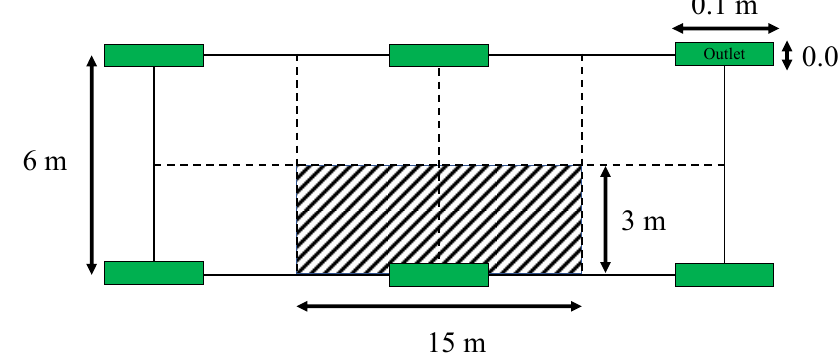
Figure 15. Horizontal view of IRD catchment area. Table 5. Boundary conditions of prototype model.